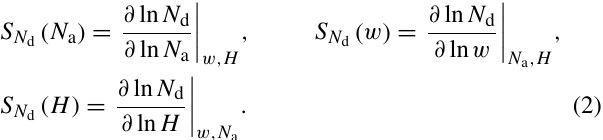
N a ≤ 500 cm − 3 ; (2) clouds under Amazonian background conditions, with 500 cm − 3 < N a ≤ 1000 cm − 3 ; (3) moder- ately polluted clouds, with 1000 cm − 3 <N a ≤ 3000 cm − 3 ; and (4) polluted clouds, with N a > 3000 cm − 3 . Solid lines in Fig. 2 represent DSDs for neutral vertical speed ( − 1 m s − 1 ≤ W ≤ 1 m s − 1 ) , while the DSDs with dashed and dotted– dashed lines indicate the updraft and downdraft regions, re- spectively ( | W | > 1 m s − 1 ; note that we use W to differenti- ate from w , which refers only to the updraft portion). They represent averages for all profiles matching the aerosol in- tervals chosen (one maritime, two Amazonian background conditions, three moderately polluted, and two polluted).